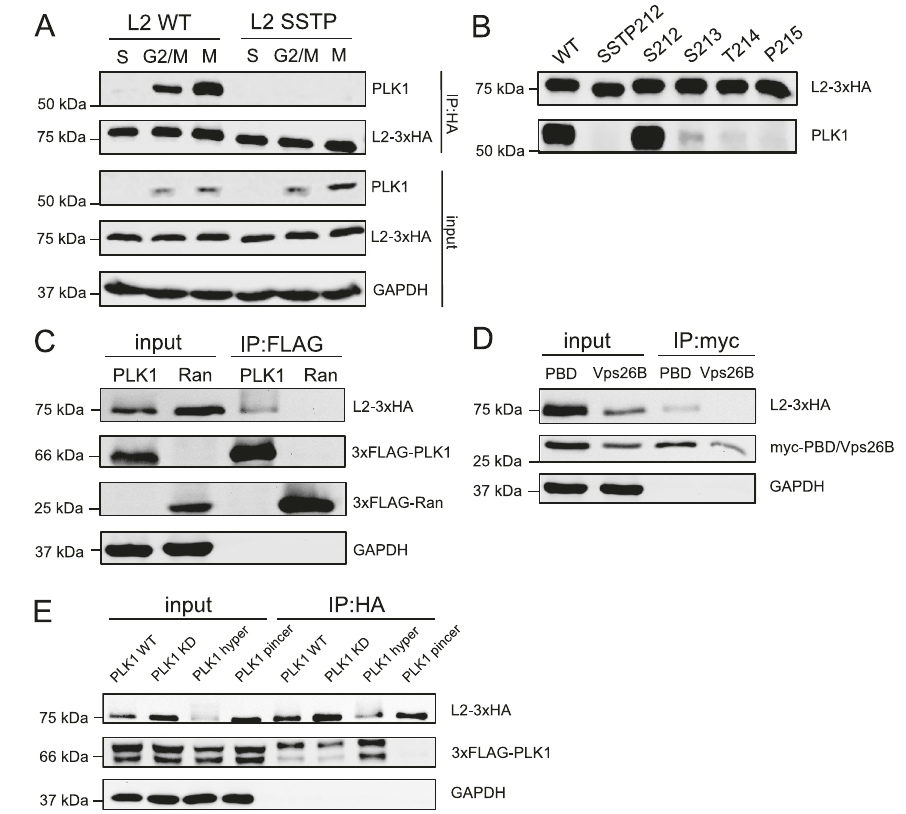
Fig. 3 | L2 SSTP motif is essential for interaction with PLK1 through the Polo- box domain. A HEK293 cells were transfected with WT and SSTP212AAAA mutant L2-3xHA expression constructs, and subsequently arrested in S-phase, M-Phase or at the G2/M border using aphidicolin (3 µ M), nocodazole (330nM) or RO-3306 (9 µ M).DepictedisarepresentativeexamplefromWesternblotanalysisagainstHA tag(BioLegend#901516),PLK1(Abcamab17057),orGAPDH(Proteintech#10494-1- AP) as loading control of SDS-PA gel electrophoresis of endogenous PLK1 immu- of myc tag PBD and Vps26B immunoprecipitates (ThermoFisher #13-2500). E HEK293cellswereco-transfectedwith3xHA-L2and3xFLAG-PLK1constructs(WT: wild type, KD: kinase dead K82R, hyper: hyper activated T210D, pincer: Polo-box domainsdead,H538AK540M).DepictedisarepresentativeexamplefromWestern blot analysis against L2 (Santa Cruz sc-65709), against FLAG tag for 3xFLAG-PLK1 (Sigma-Aldrich #F1804), against GAPDH (Proteintech #10494-1-AP) and of SDS-PA gel electrophoresis of L2-3xHA (Santa Cruz sc-65709) and 3xFLAG-PLK1 (Sigma- Aldrich #F1804), immunoprecipitates. Representative blots for three independent experiments are shown. Source data are provided as a Source Data fi